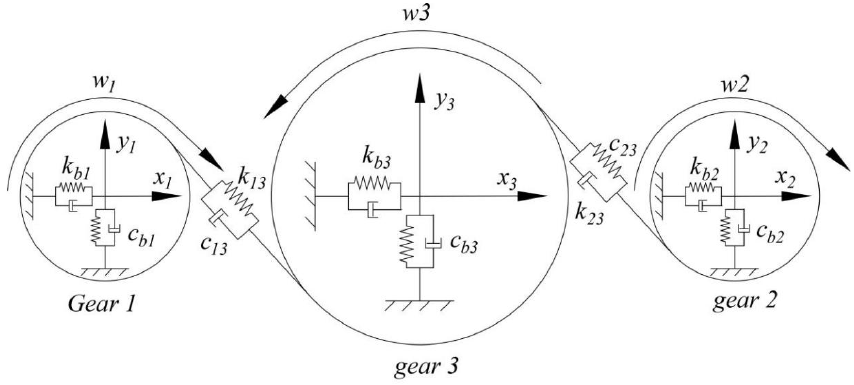
Figure 3. Dynamic model of the fixed axle gear train.